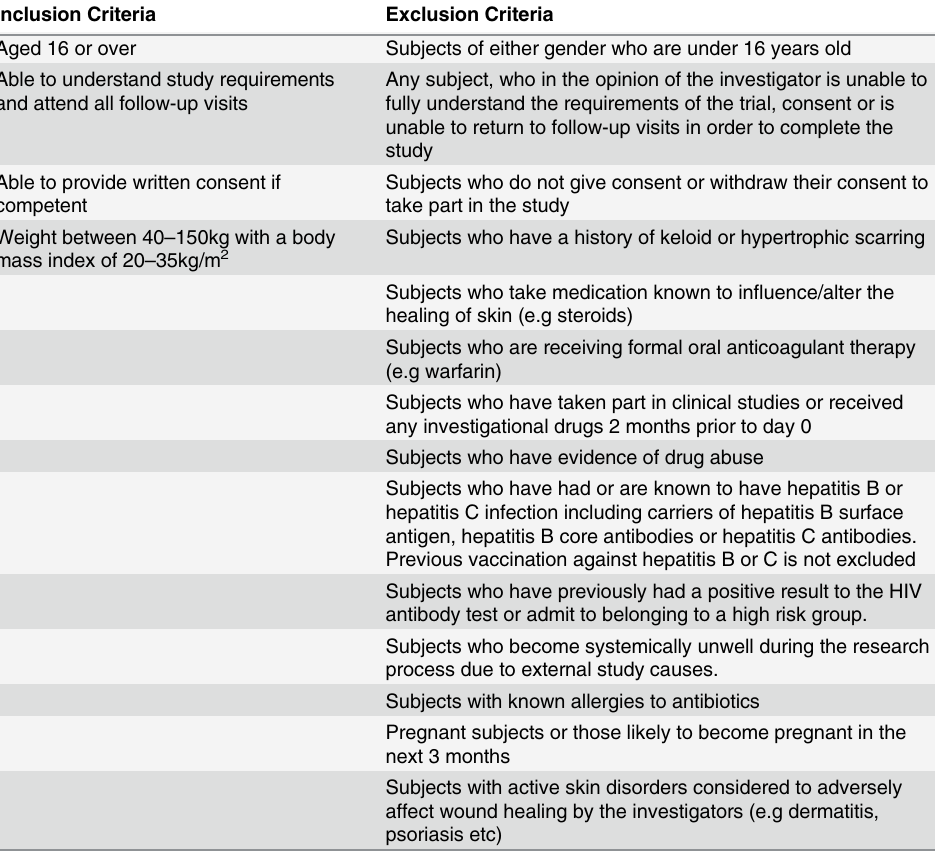
Table 1. Study inclusion and exclusion